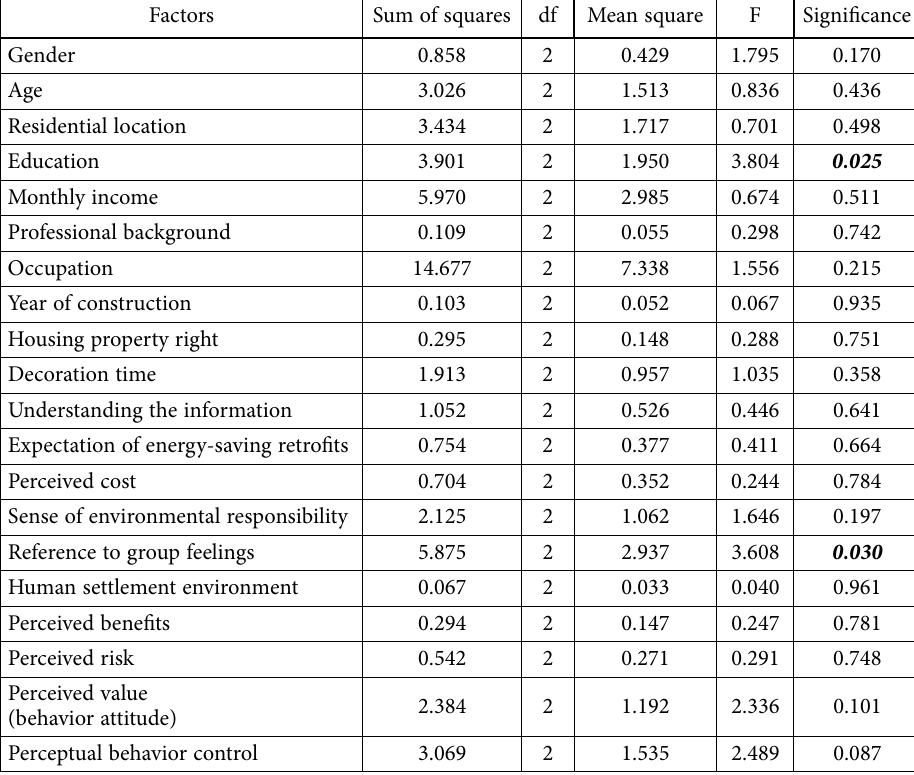
Table 8. Variance analysis table of influencing factors and energy-saving retrofit